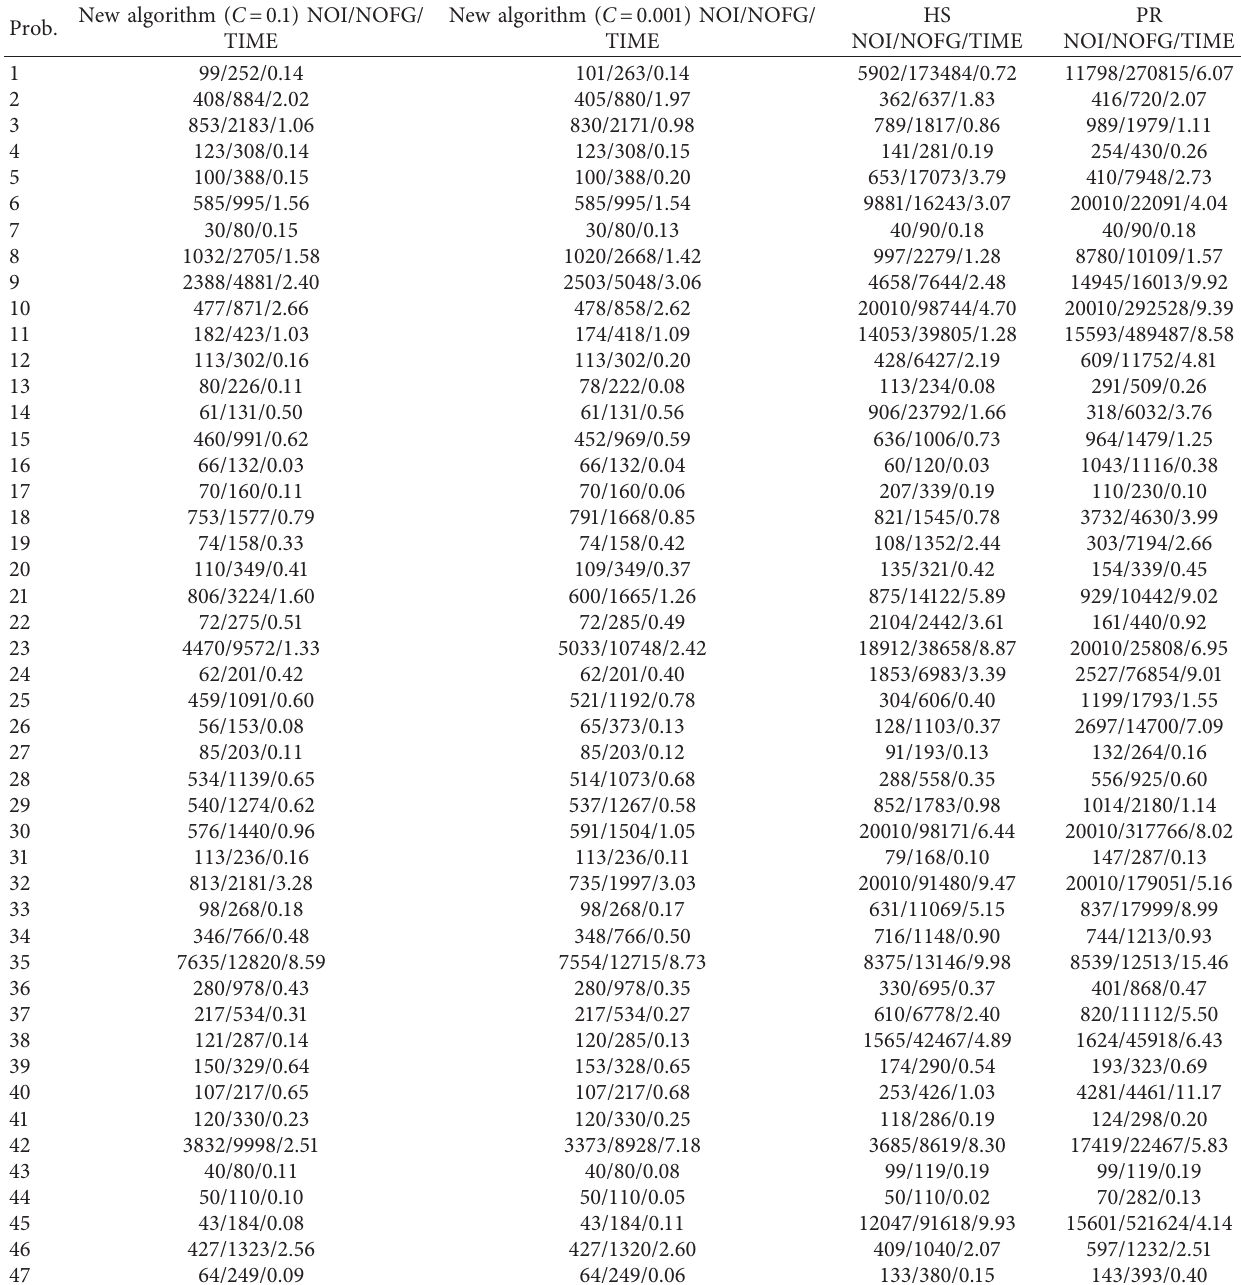
Table 2: Comparisons of new algorithm against (HS) & (PR) algorithms for the total of (60) test problems with (1000 ≤ n ≤ 10000, and the increasing size in n is equal to 1000) with ( c � 0.1 and